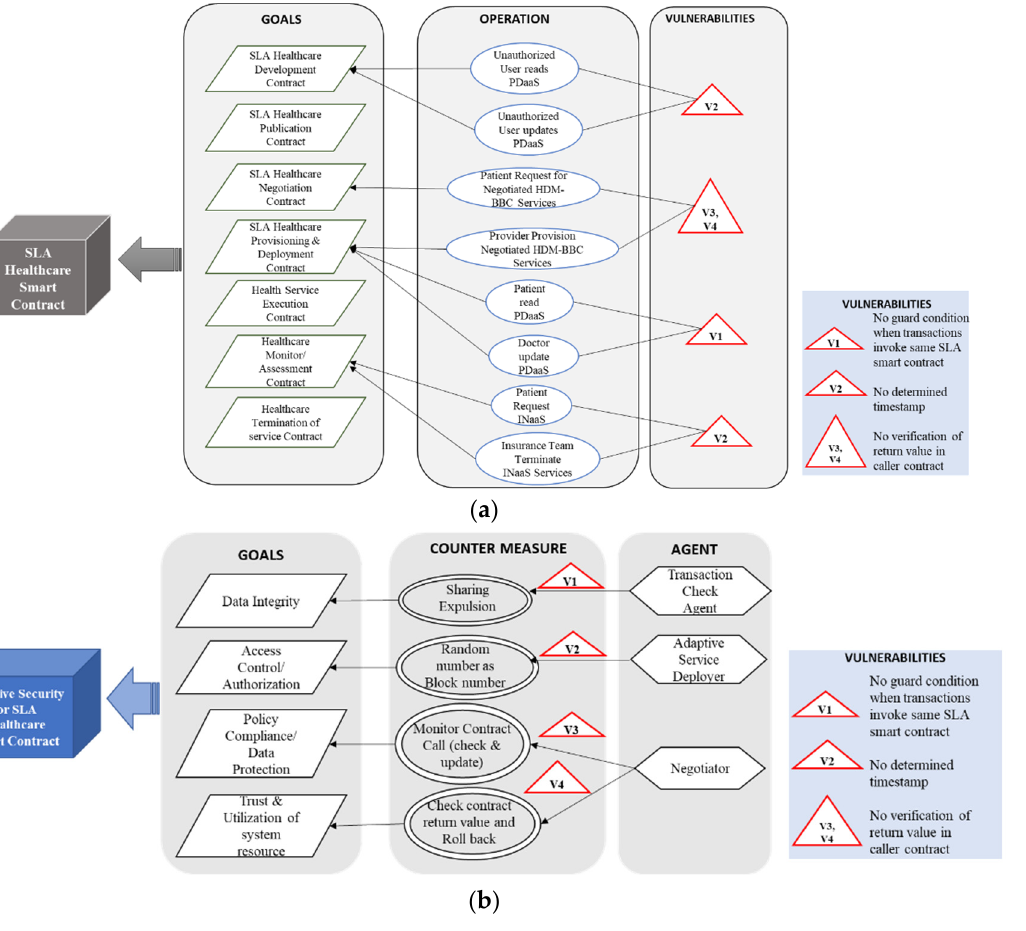
Figure 11. ( a ) Goal model for SLA healthcare smart contract. ( b ) Adaptive security goal model for SLA healthcare smart contract.